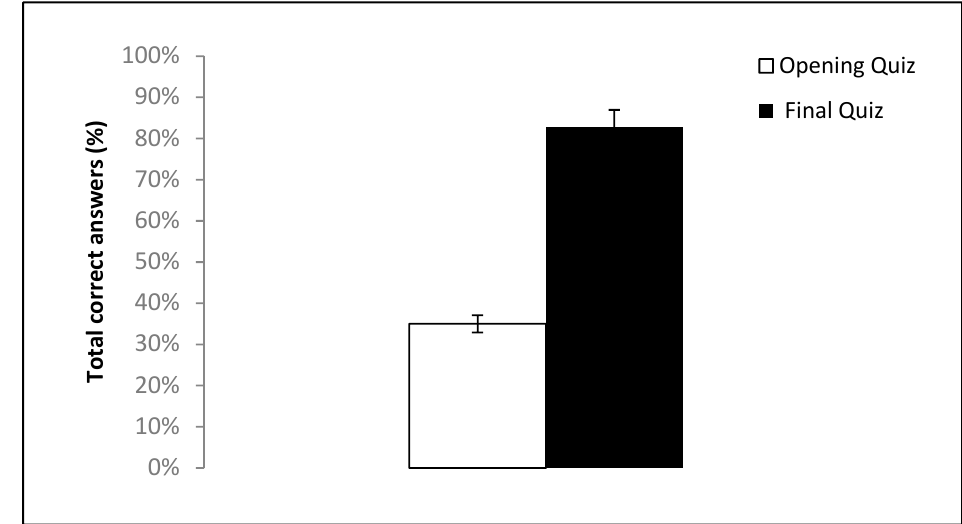
Figure 4. Total correct answers in the opening and final questionnaires.